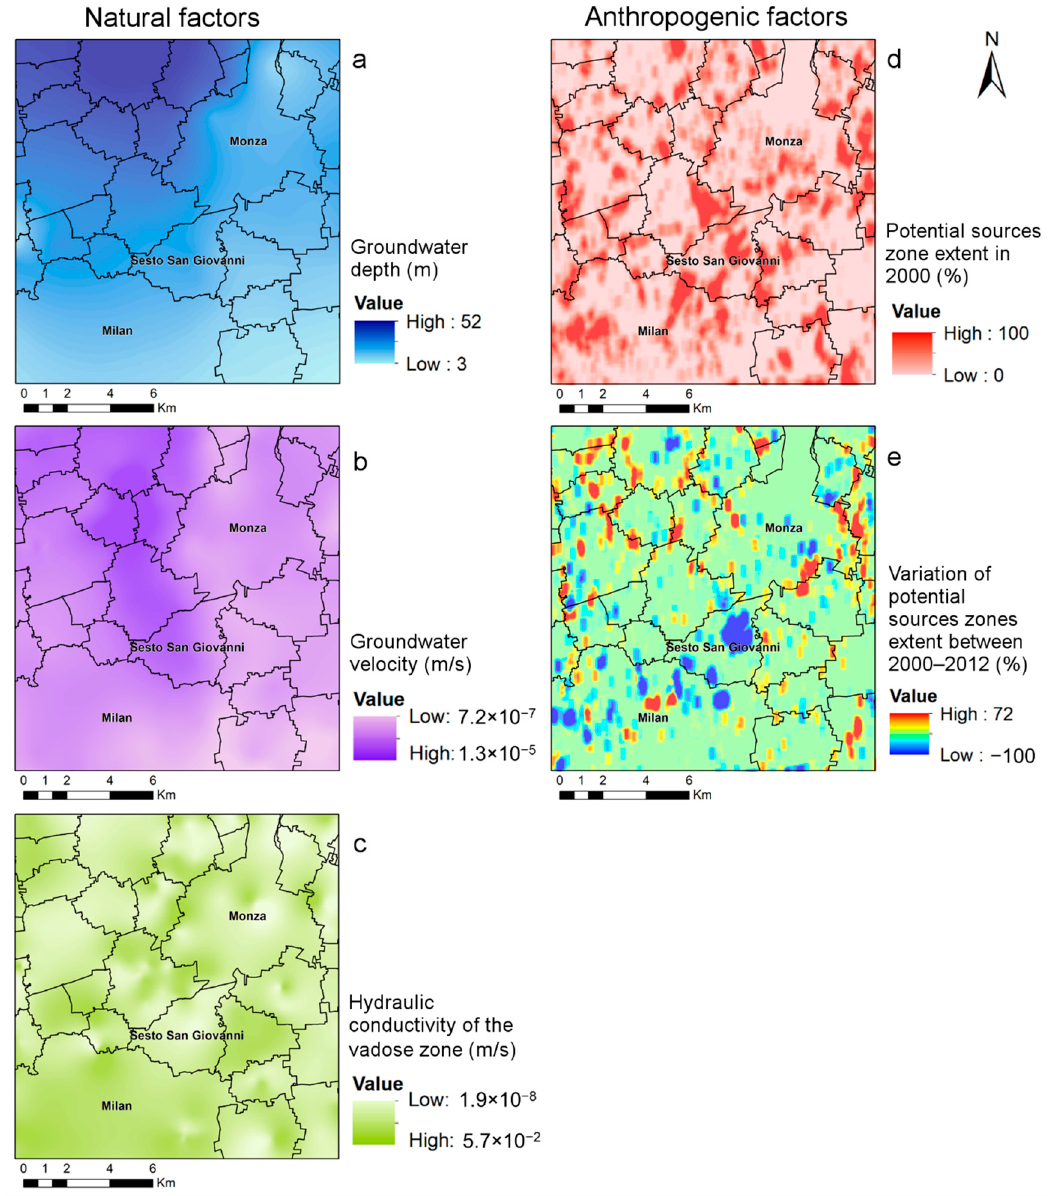
Figure 4. Natural and anthropogenic factors influencing groundwater contamination: ( a ) groundwater depth; ( b ) groundwater velocity; ( c ) hydraulic conductivity of the vadose zone; ( d ) potential sources zone (PSZ) extent in 2000; ( e ) variation of PSZ extent between 2000 and 2012.